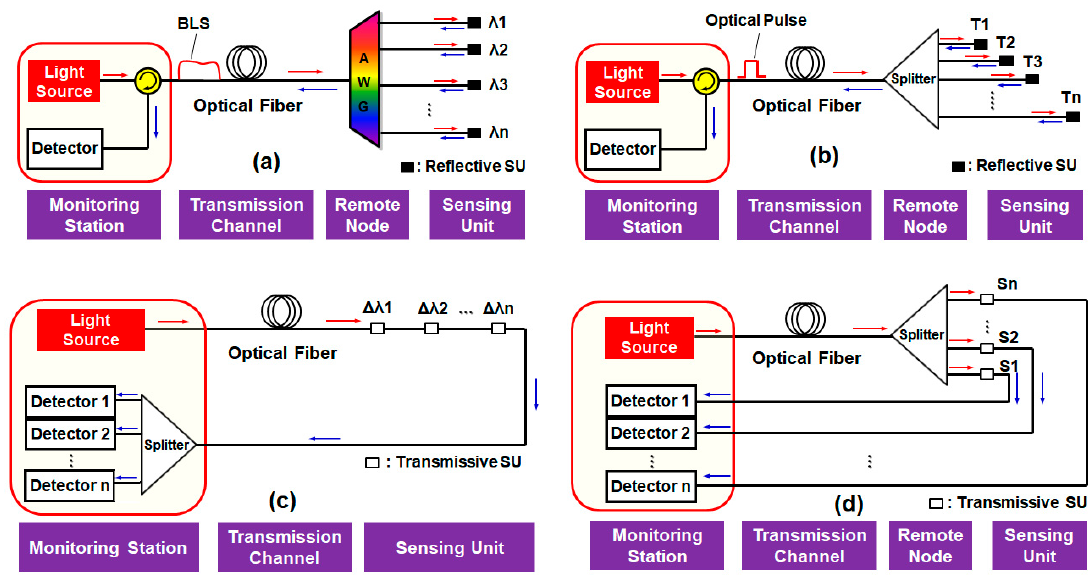
Figure 3. Basic architectures for various multiplexing techniques: ( a ) wavelength division multiplexing (WDM), ( b ) time division multiplexing (TDM), ( c ) coherence division multiplexing (CDM), and ( d ) space division multiplexing (SDM). SU: sensing unit and AWG: arrayed waveguide grating. λ n , Tn , ∆ λ n and Sn represent the channel numbers of the allocated wavelength, time, coherence length and space for multiplexing/demultiplexing, respectively.